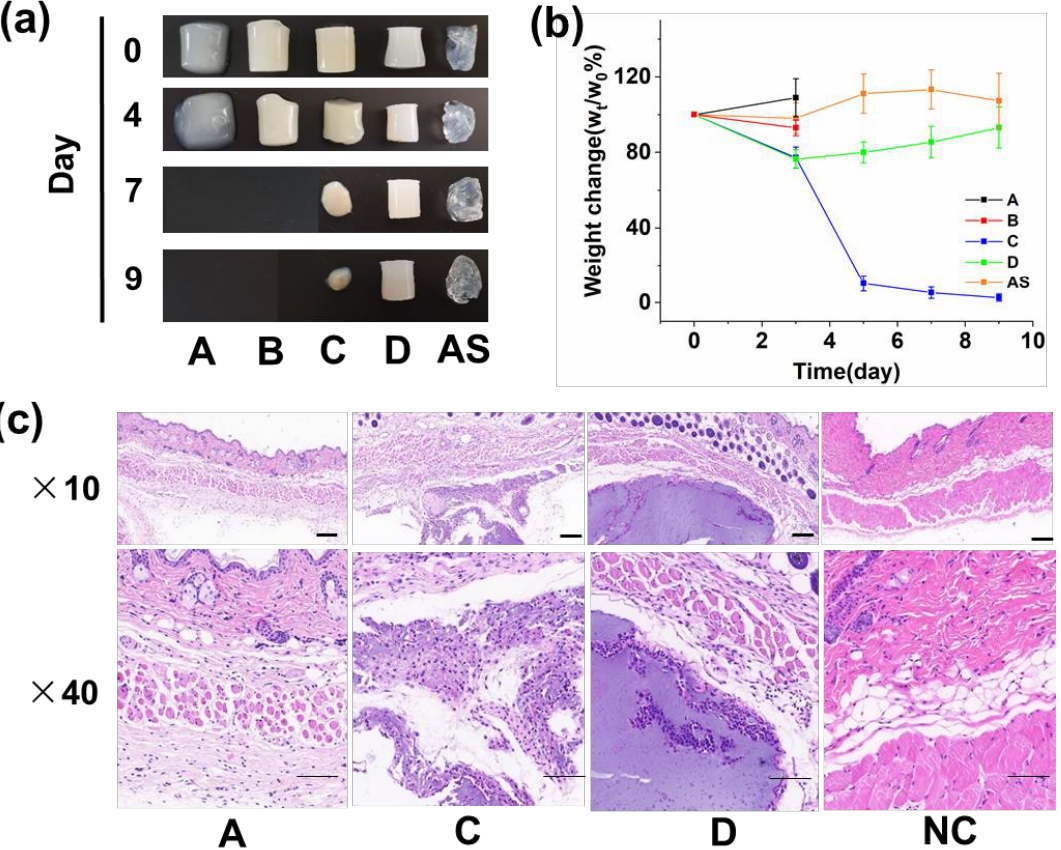
Figure 6. The degradation profile in vitro and in vivo (Scale bar = 200 µ m). ( a , b ) The hydrogel degradation behaviors in vitro were investigated during a 9-day period. The photographs of the undegraded gel were taken ( a ) and their weight was measured at fixed intervals ( b , c ) The biodegradation behaviors in vivo were investigated 20 days after the gels were implanted in the mice.